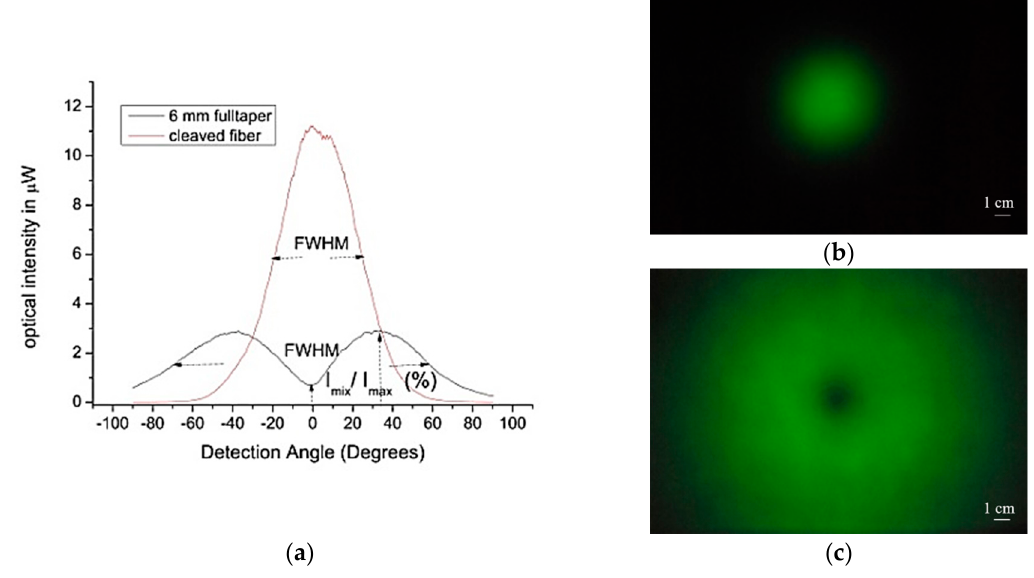
Figure 7. ( a ) Goniometric measurements of beams from a taper (twin peaks) and a flat polished fiber (single peak ( b ) Picture of beam profile from a flat polished fiber, projected on a screen, ( c ) and that of a taper.